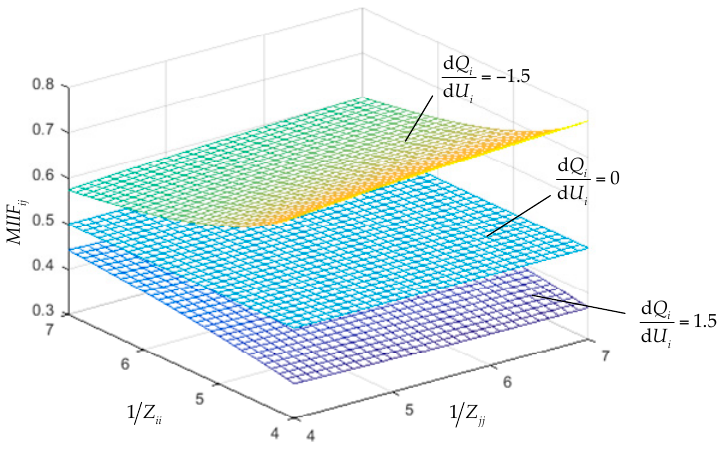
Figure 6. MIIF versus the inverses of self-impedances.